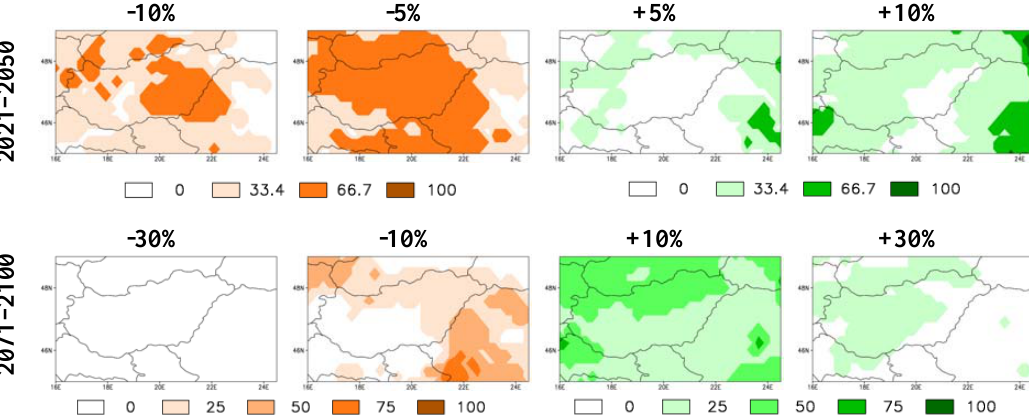
Fig. 5. Probability (%) of winter precipitation change larger than 5, 10 and 30 percent for 2021–2050 and 2071–2100 relative to 1961–1990. Colors indicate in percentage how many out of three/four models are projecting a signal exceeding a selected threshold. Hungarian National Science Research Foundation under